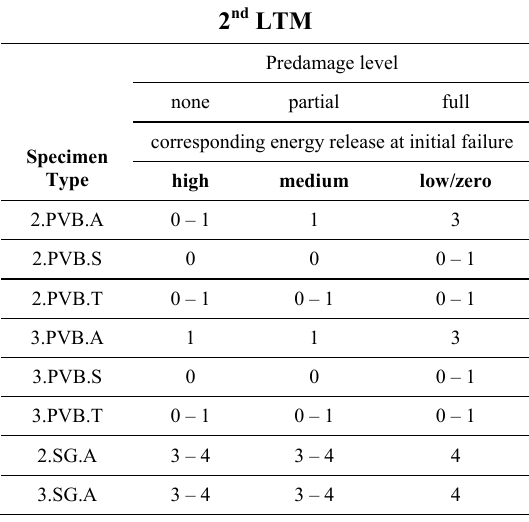
Table 1: 2 nd Load Transfer Mechanism per specimen type, per predamage level – sorted by beam type. A ‘0’ means there is no 2 nd LTM is